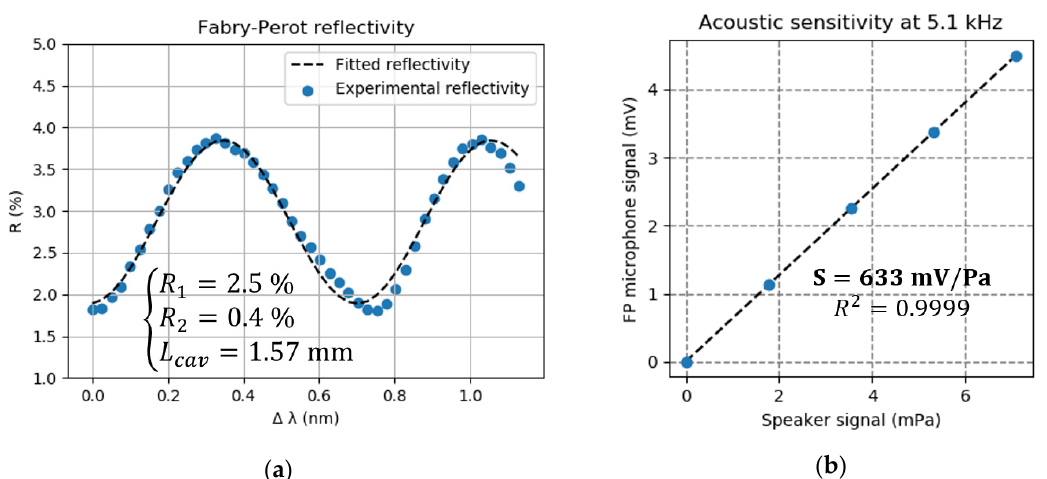
Figure 13. ( a ) Interference pattern of the transducer FP cavity as a function of the relative wavelength shift ∆ λ around 1.55 µ m; ( b ) Acoustic calibration of the FP transducer at the hinged cantilever resonance frequency (5.1 kHz).